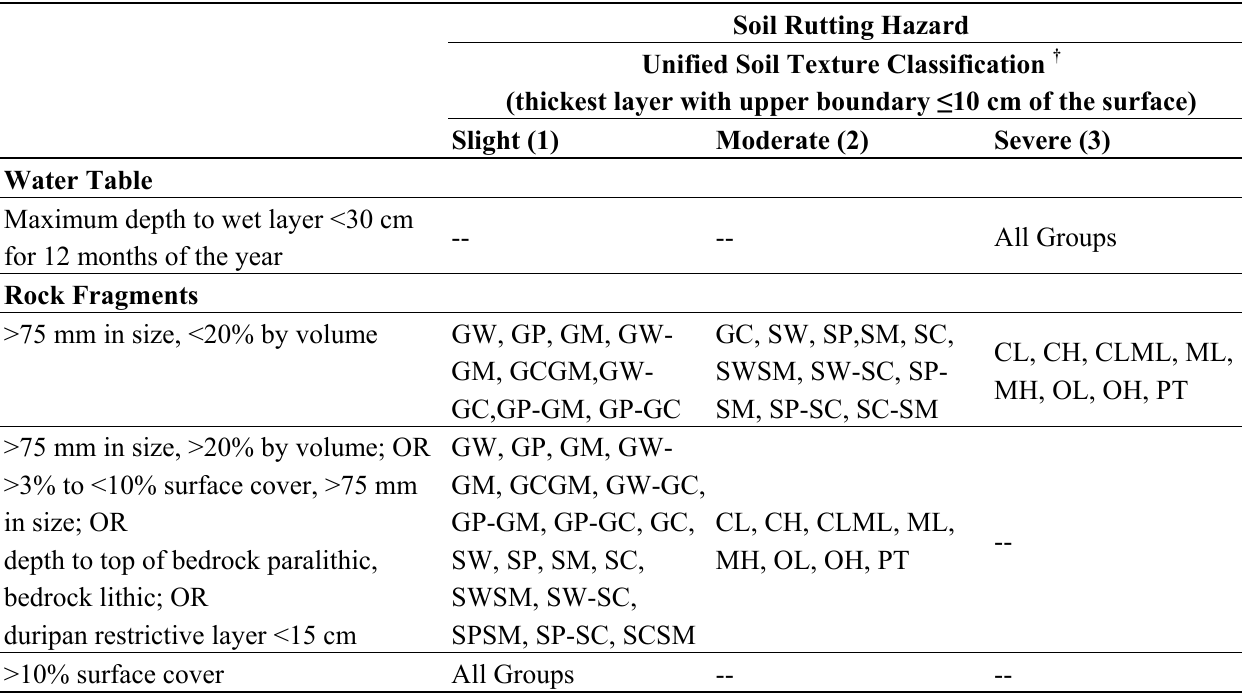
Table 2. NRCS soil rutting hazard as a function of soil texture, depth to water table and soil rock fragment content for the ID612 survey area of the Northern Rockies